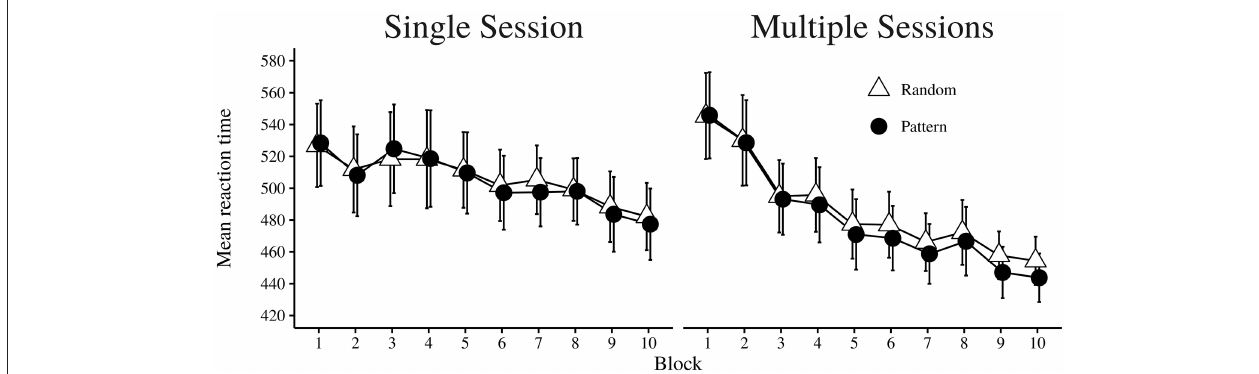
FIGURE 6 | Mean of median reaction time in milliseconds for pattern and random trial types, shown independently for each condition over each block. Error bars indicate 95% CI.